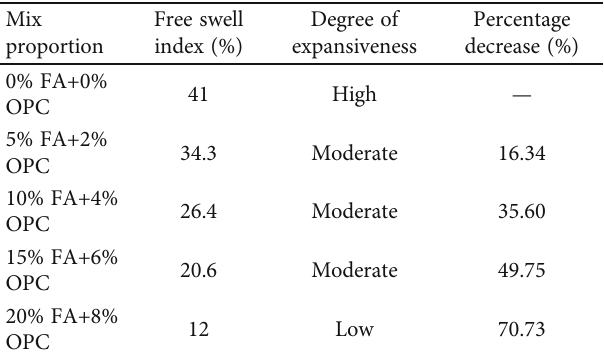
Figure 3: E ff ect of fl y ash and cement on PL, LL, and PI. Table 4: E ff ects by fl y ash and cement on the FSI